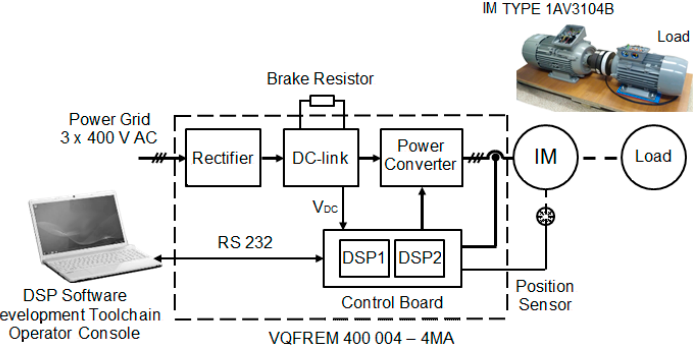
Figure 14. The structure of the experimental setup with VQFREM 400 004–4MA power converter.